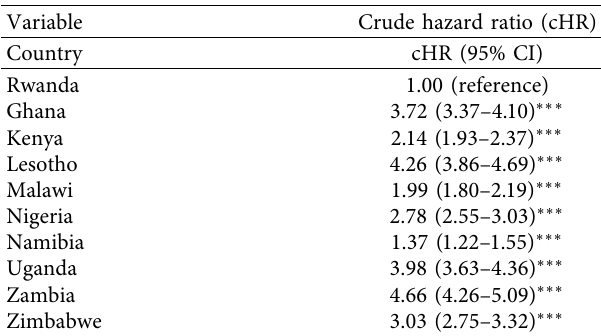
Table 3: Bivariate analysis of higher-risk sexual behavior with